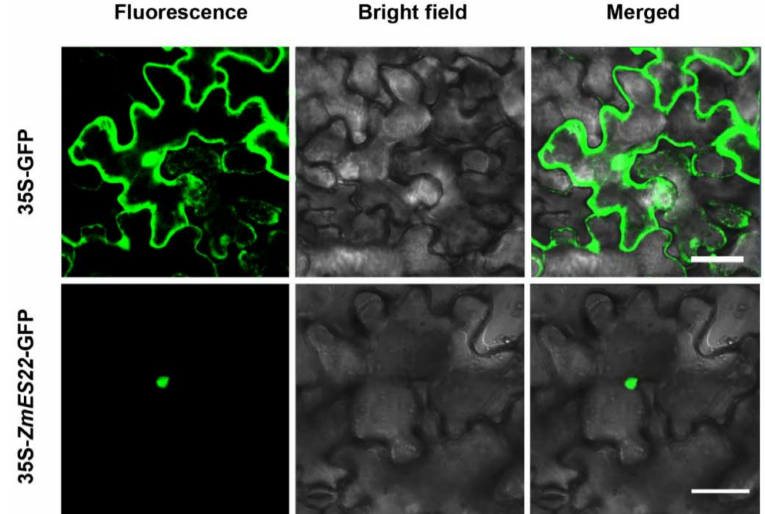
Figure 3. Subcellular localization of ZmES22 in tobacco. The 35S:: ZmES22 -GFP fusion construct and 35S::GFP vector were transiently expressed in tobacco epidermal cells and examined by a confocal laser scanning biological microscope, respectively. Bars = 50 µ